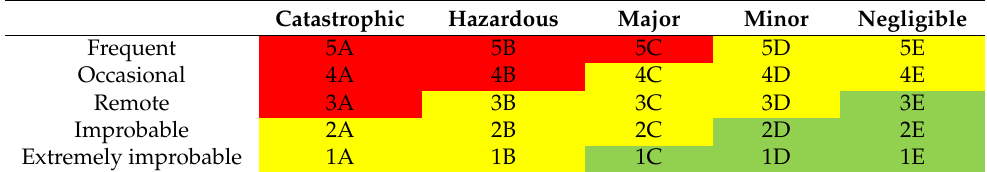
Table 5. The ICAO risk